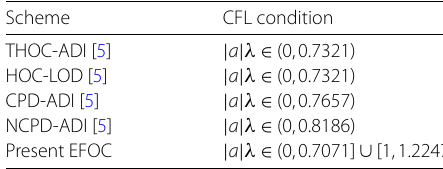
Table 1 CFL conditions for various finite difference schemes Scheme CFL condition THOC-ADI [5] | a | λ ∈ (0,0.7321) HOC-LOD [5] | a | λ ∈ (0,0.7321) CPD-ADI [5] | a | λ ∈ (0,0.7657) NCPD-ADI [5] | a | λ ∈ (0,0.8186) Present